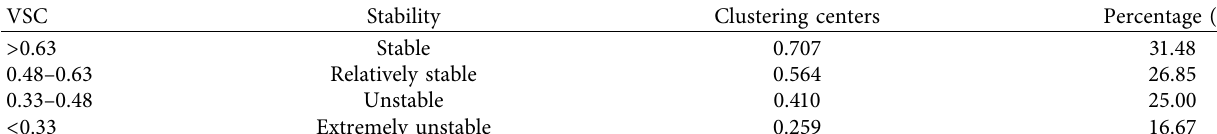
Table 13: Visual stability evaluation criteria based on cluster analysis.